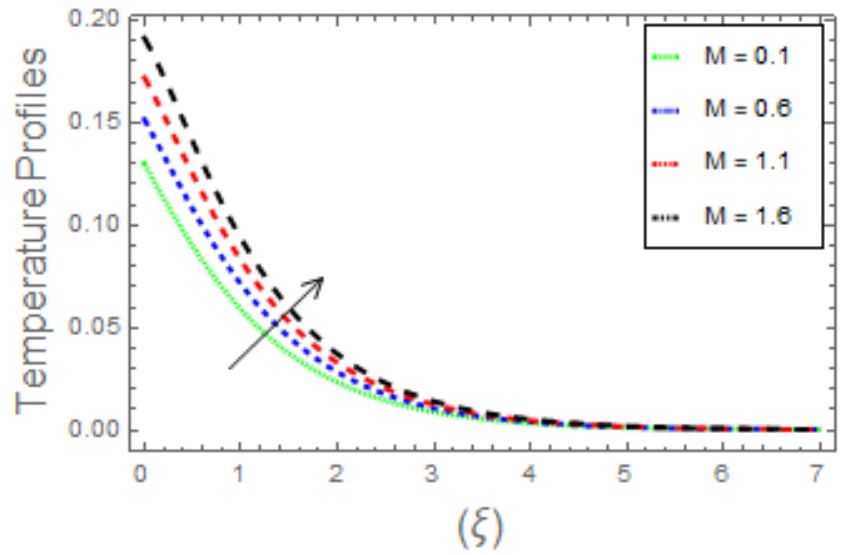
Figure 7. It is observed that the f (cid:48) ( ξ ) distribution increases, as the value of λ increases, due to the buoyancy factor.